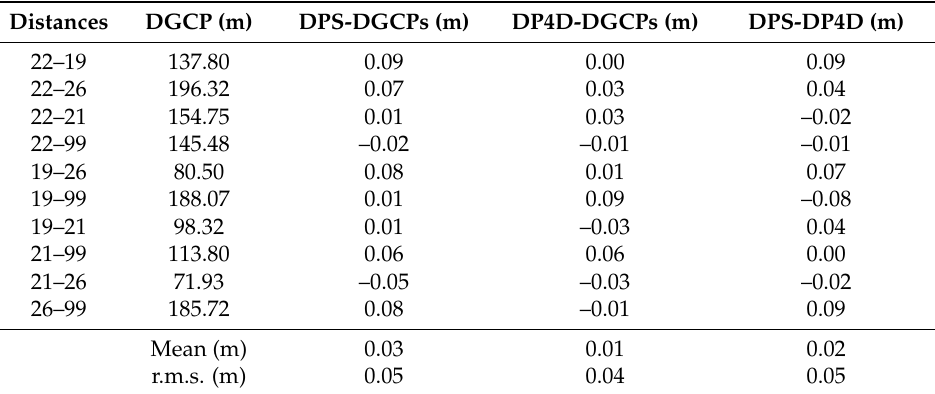
Figure 13. The buildings whose areas and volumes were measured. Table 5. Results of the distance